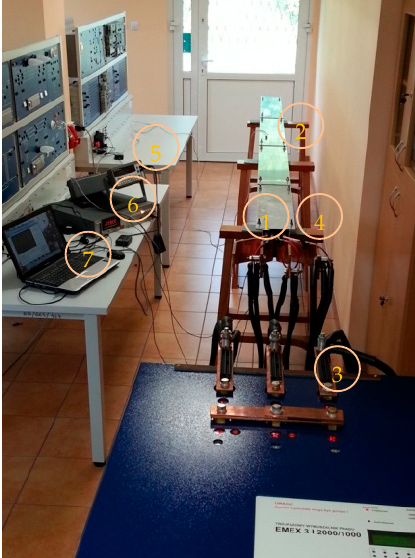
Figure 7. Measurement stand: 1—busbar manufactured by the Holduct company [5], 2—shield cover, 3—current transformer, 4—Rogowski coils, 5—voltmeter, 6—phase meter, 7—PC with measurement software.